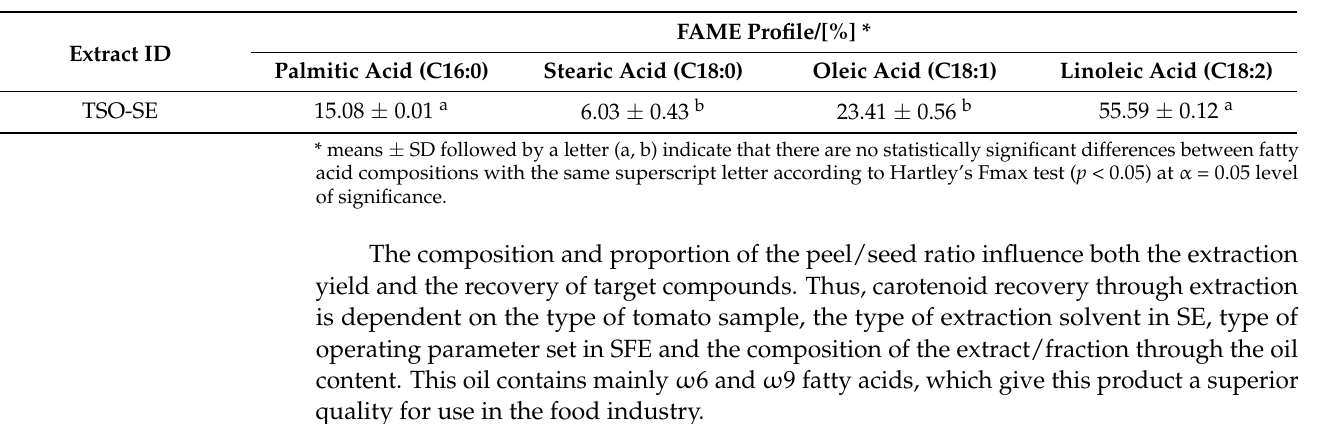
Table 5. FAME composition of tomato seed